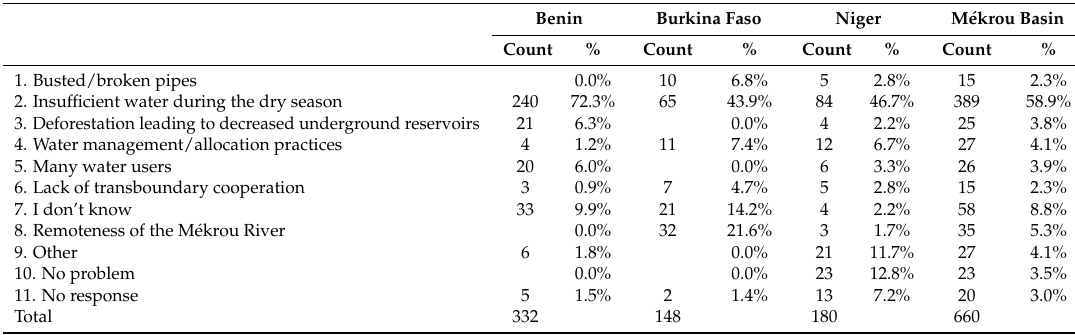
Table 7. Main water provision related problem in the M é krou